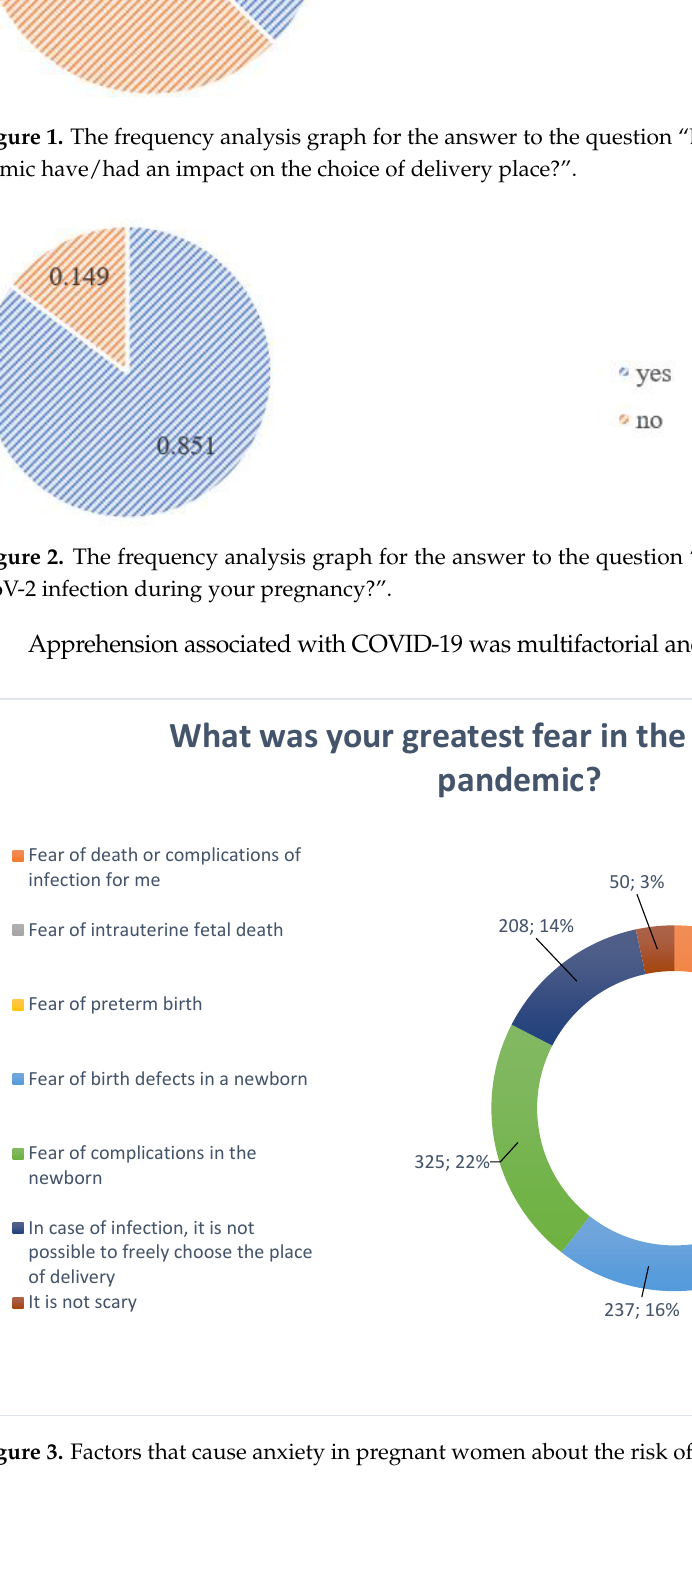
Figure 4. The frequency analysis graph for the answer to the question “ How has the SARS-CoV-2 pandemic affected your pregnancy visits? ” .